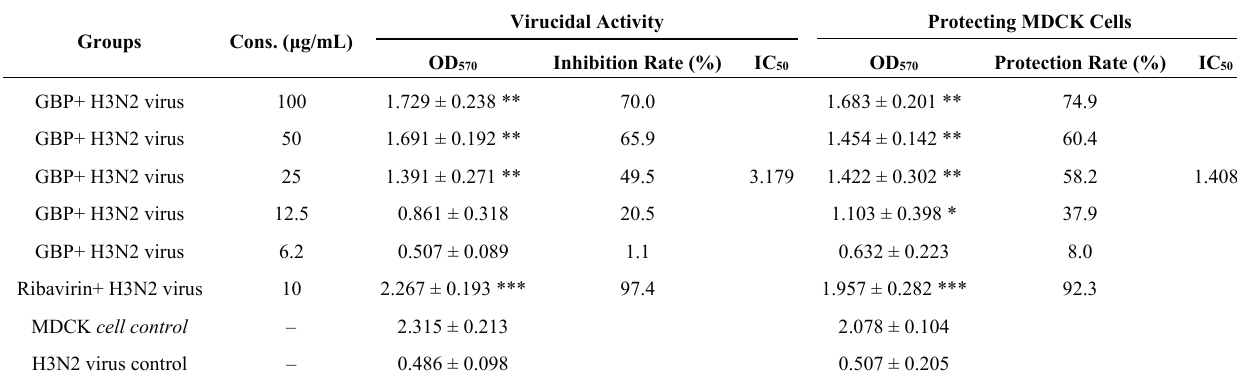
Table 2. Effect of GBP on H3N2 influenza virus and MDCK cells ( χ ± s, n =